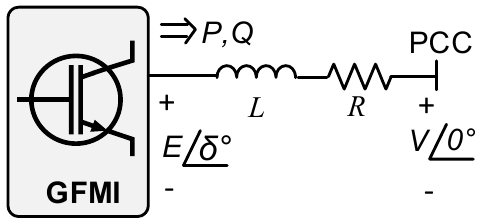
Figure 5. Circuit Diagram Describing the Power Flow of a Grid-Forming Inverter.